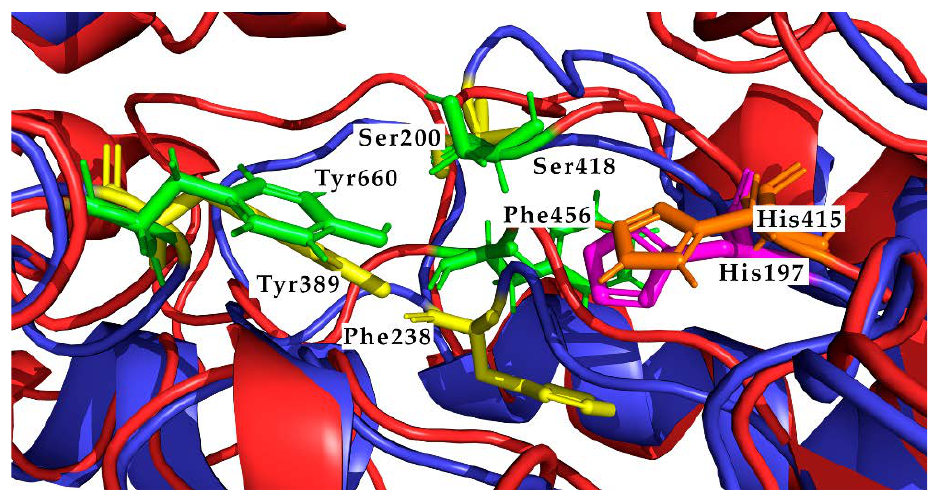
Figure 6. Detail of the active site structure of Human ODC (2ON3) and the active site of L. amazonensis ODC modeled obtained by structural alignment. Blue—Human structure (2ON3). Red— L. amazonensis modeled structure. Catalytic residues are shown in sticks. Yellow—Catalytic residues Ser200, Phe238 and Tyr389 determined by Dufe et al. [53] are shown in sticks. Green—Catalytic residues Ser418, Phe456, and Tyr660 determined by structural alignment. In addition, His197 (magenta) and His415 (orange) that could be involved in the stabilization of reaction intermediates have been rendered.